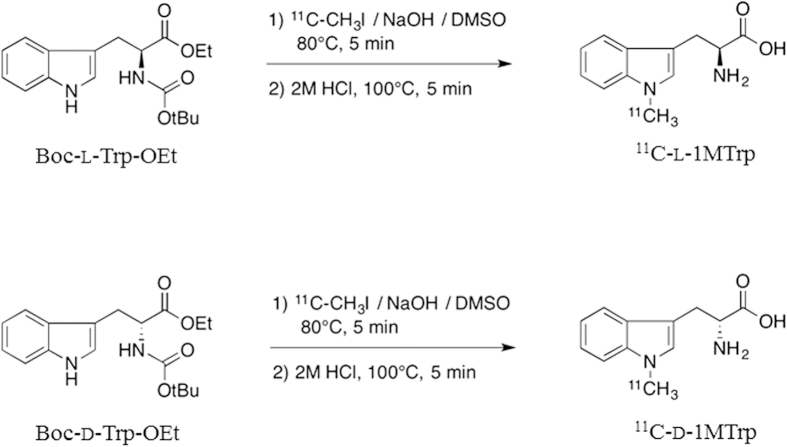
Chemical scheme for radiosynthesis of 11C- l-1MTrp and 11C-d-1MTrp.